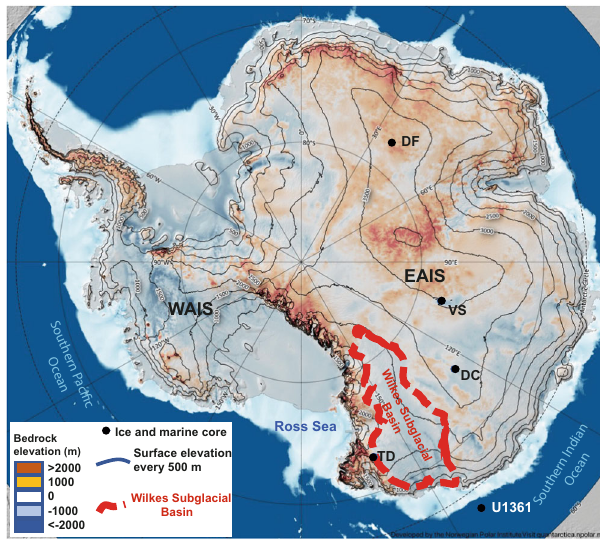
Fig. 1 | Location of main Antarctic ice core drilling sites and the marine sedi- ment core at Site U1361. The map shows the subglacial bedrock elevation above sealevel(colourscale,m)andtheAntarcticicesheetpresent-daysurfaceelevation abovesealevel(contours,m) 6 .TheicecoredrillingsitesofTalosDome(TD),Dome C (DC), Vostok (VK), and Dome F (DF) and the marine sediment core at Site U1361 are indicated with blue dots. The studied area of the Wilkes Subglacial Basin is delimited by the red dashed contour. Map created using the Quantarctica GIS package 69 developed by the Norwegian Polar Institute and published under